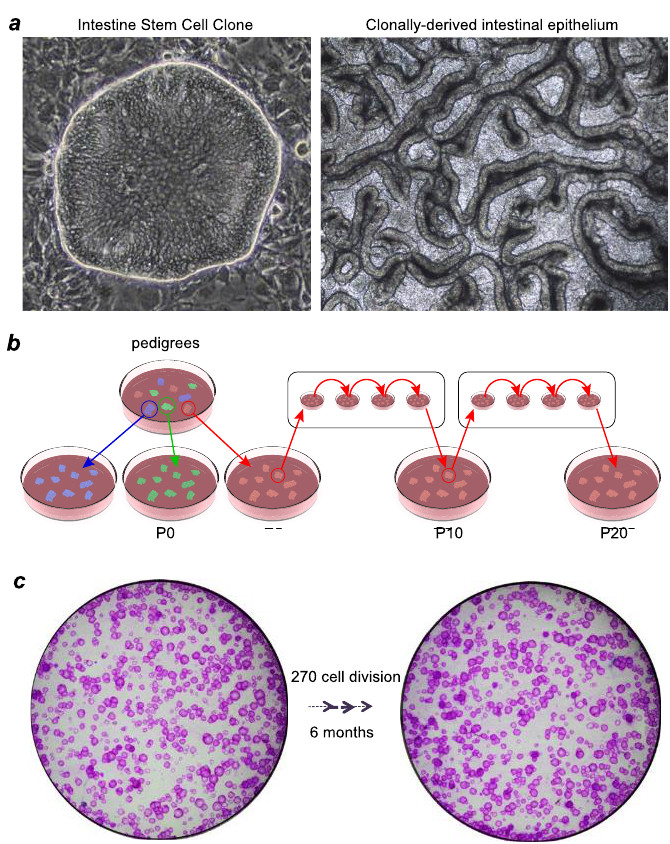
Figure 1. Xian–McKeon method of cloning ground-state intestinal stem cells. ( a ) Right, Representative image of a single-cell derived ISC GS colony. Left, Top view of in vitro intestinal epithelium generated from stem cells of a pedigree of ISC GS differentiated in an air–liquid interface setting. ( b ) Schematic diagram of establishing pedigrees from ISC GS . Long-term culturing does not affect the capacity of ISC GS to form single-cell derived pedigrees. ( c ) Clonogenicity assay revealing nearly unchanged number of Rhodamine red-stained colonies despite long-term culturing.